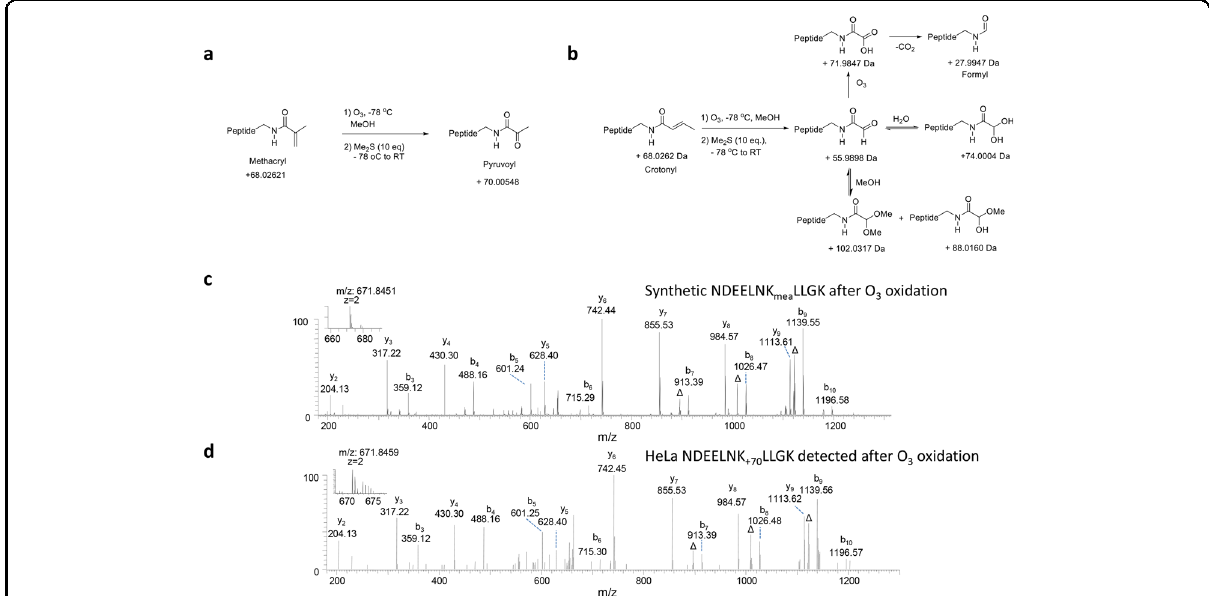
Fig. 2 Veri fi cation of Kmea structure by ozone (O3) oxidation. a , b Chemical reactions for ozonolysis of the double bonds in Kmea ( a ) and Kcr ( b ) peptides. c MS/MS of ozonolyzed peptides. The synthetic H2AK95mea peptide, NDEELNKmeaLLGK, was subjected to ozonolysis reaction. Its main reaction product, NDEELNK + 70 LLGK, was analyzed by HPLC/MS/MS analysis. d MS/MS of a NDEELNK + 70 LLGK peptide detected in O3 oxidized HeLa histone